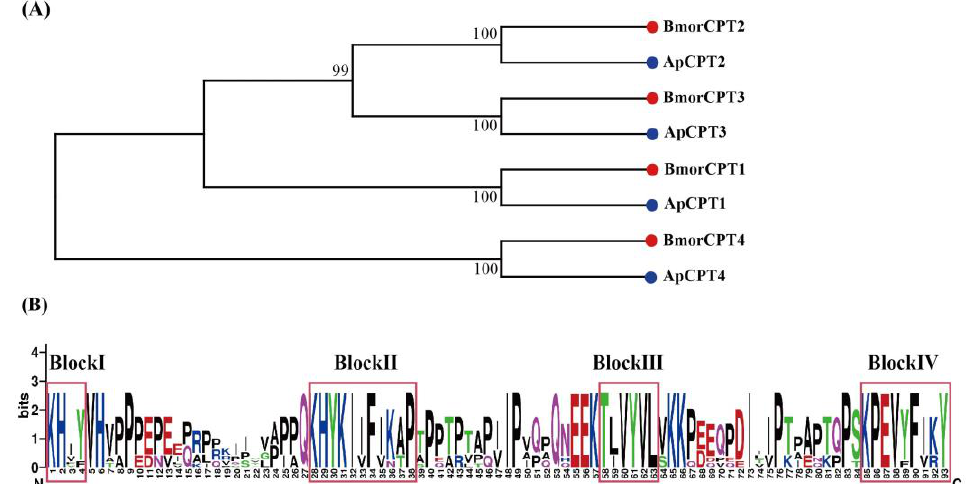
Figure 5. Phylogenetic tree ( A ) and sequence logo of the conserved region ( B ) of Tweedle protein family in A. pernyi (Ap; blue circle) and B. mori (Bmor; red circle). The sequence logo was generated by Weblogo [34].